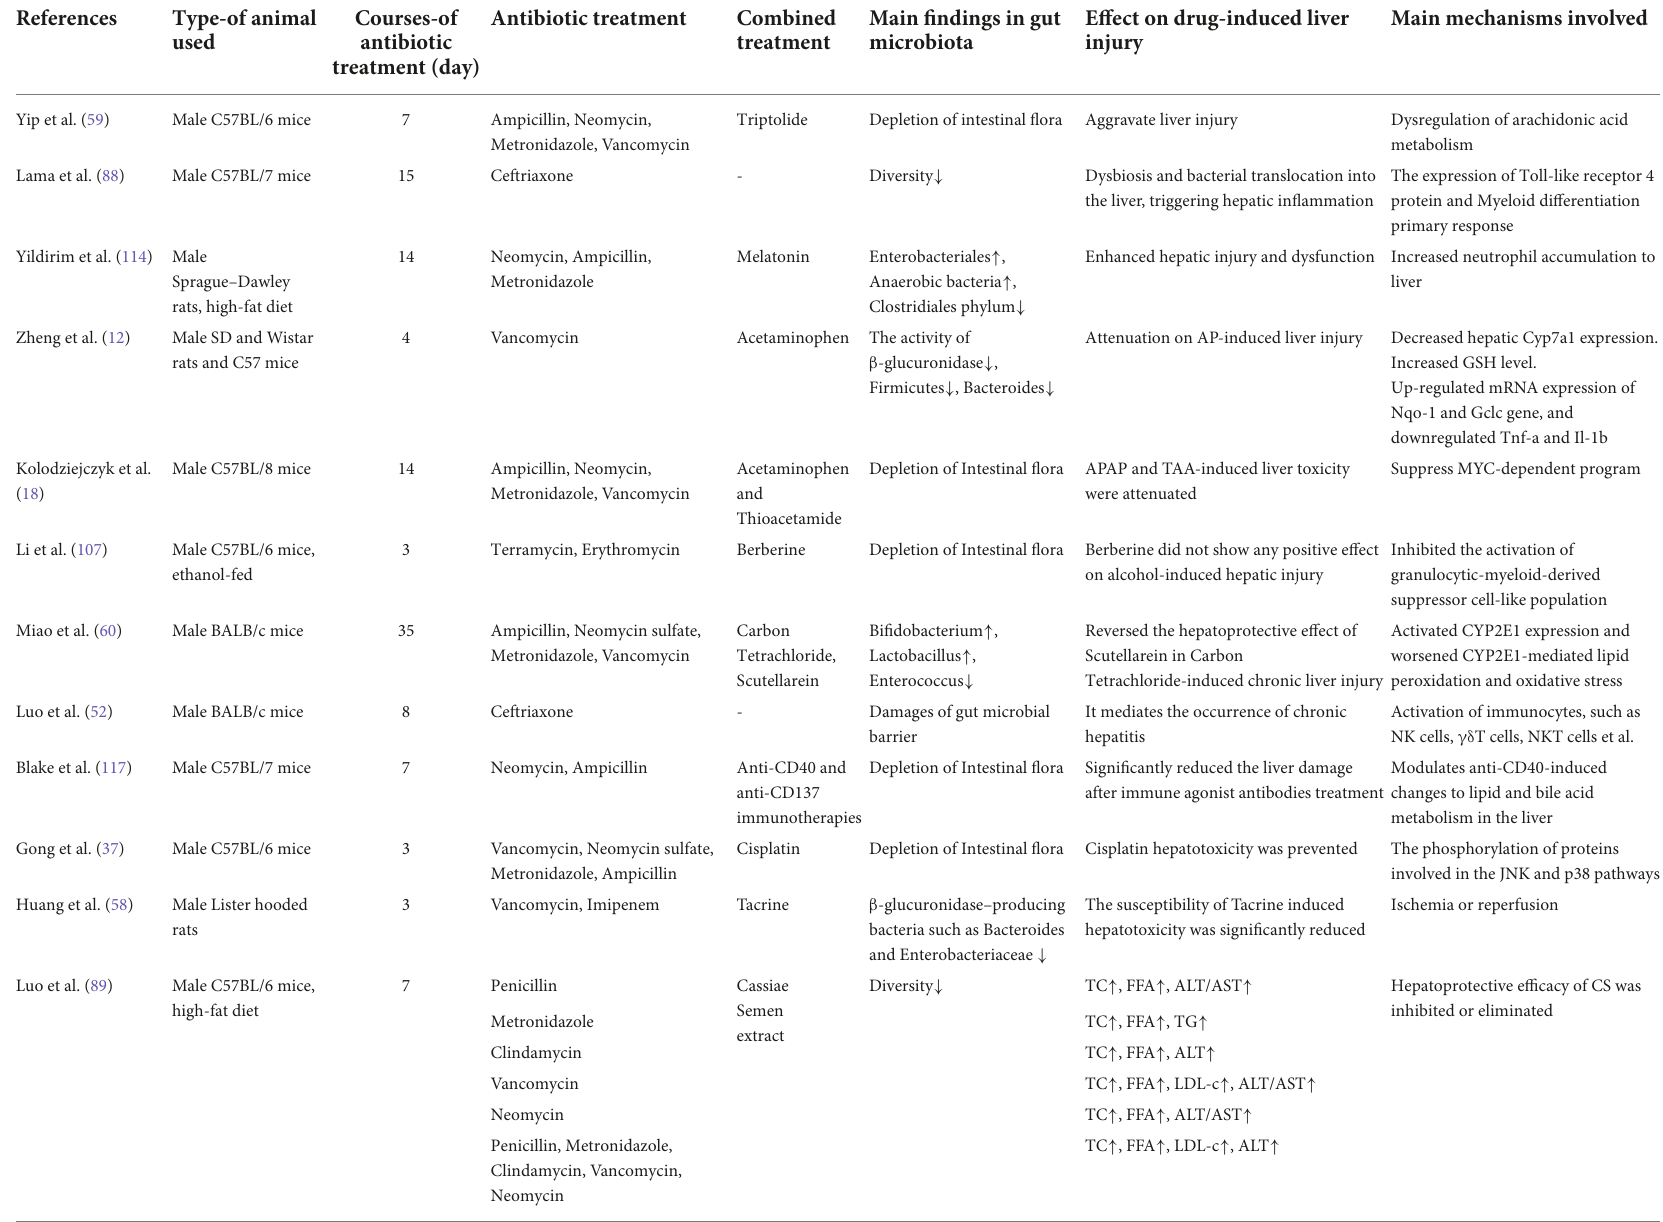
TABLE 2 List of main studies in animals associating antibiotics treatment and drug induced liver